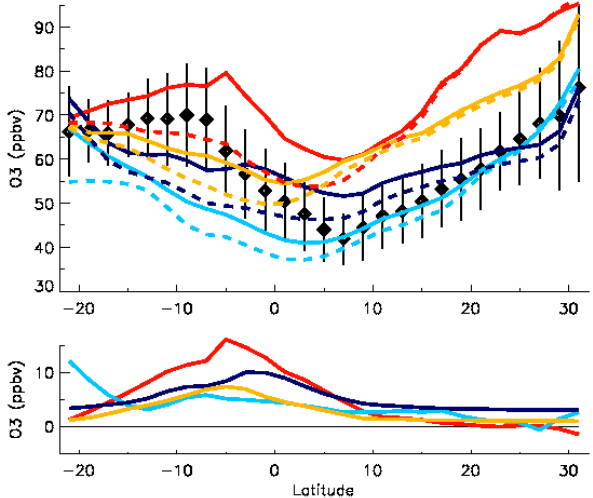
Fig. 5. Same as Fig. 4 but for O 3